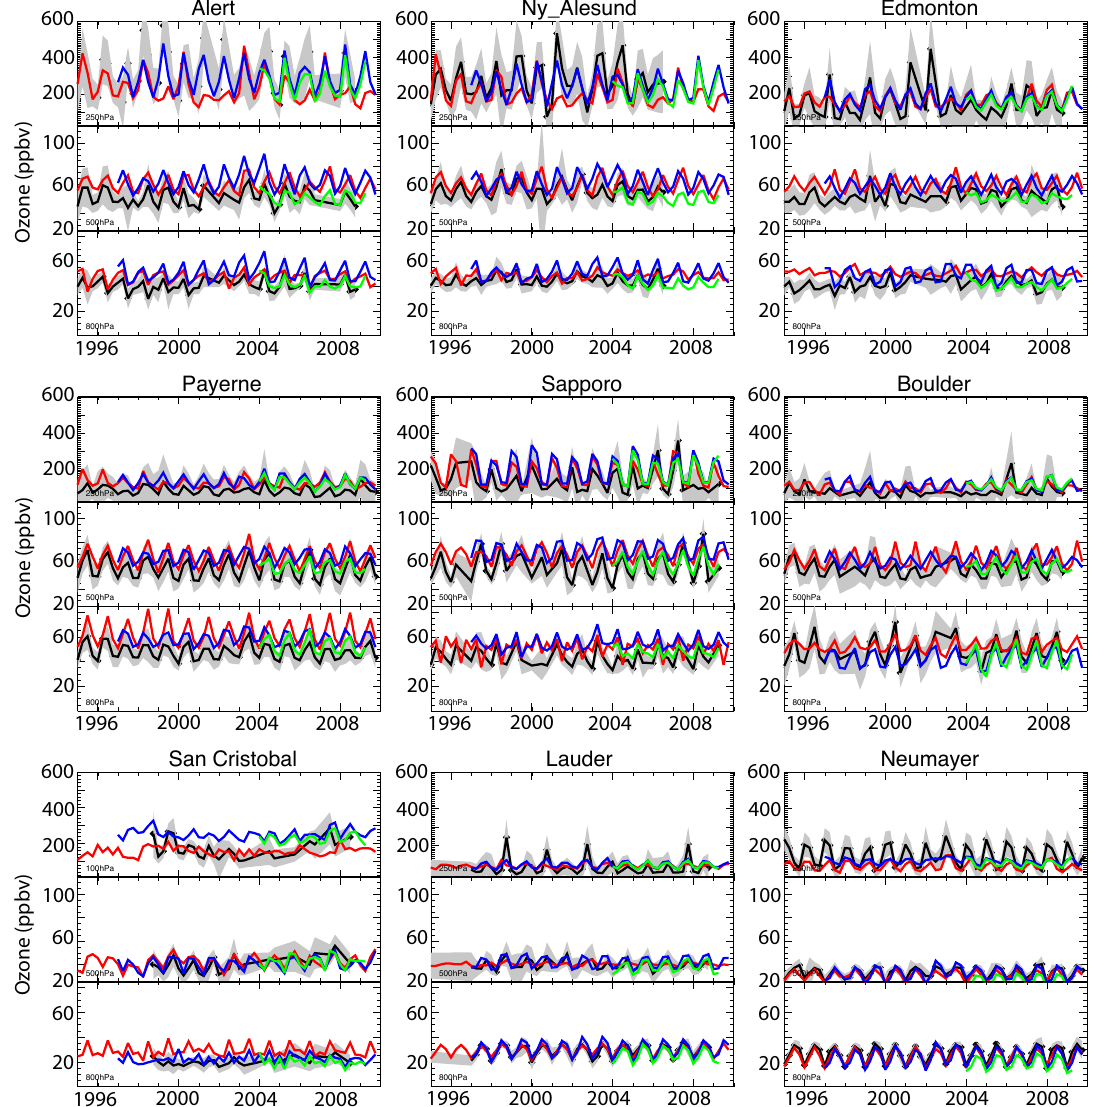
Fig. 7. Long-term change in median observed (grey shading indicates variability within the season) and simulated tropospheric ozone (top: 250hPa, middle: 500hPa and bottom: 800hPa) for a variety of stations spanning the globe. Seasonal averages are shown. Black line is observations, red line is online, green line is GEOS5 and blue line is